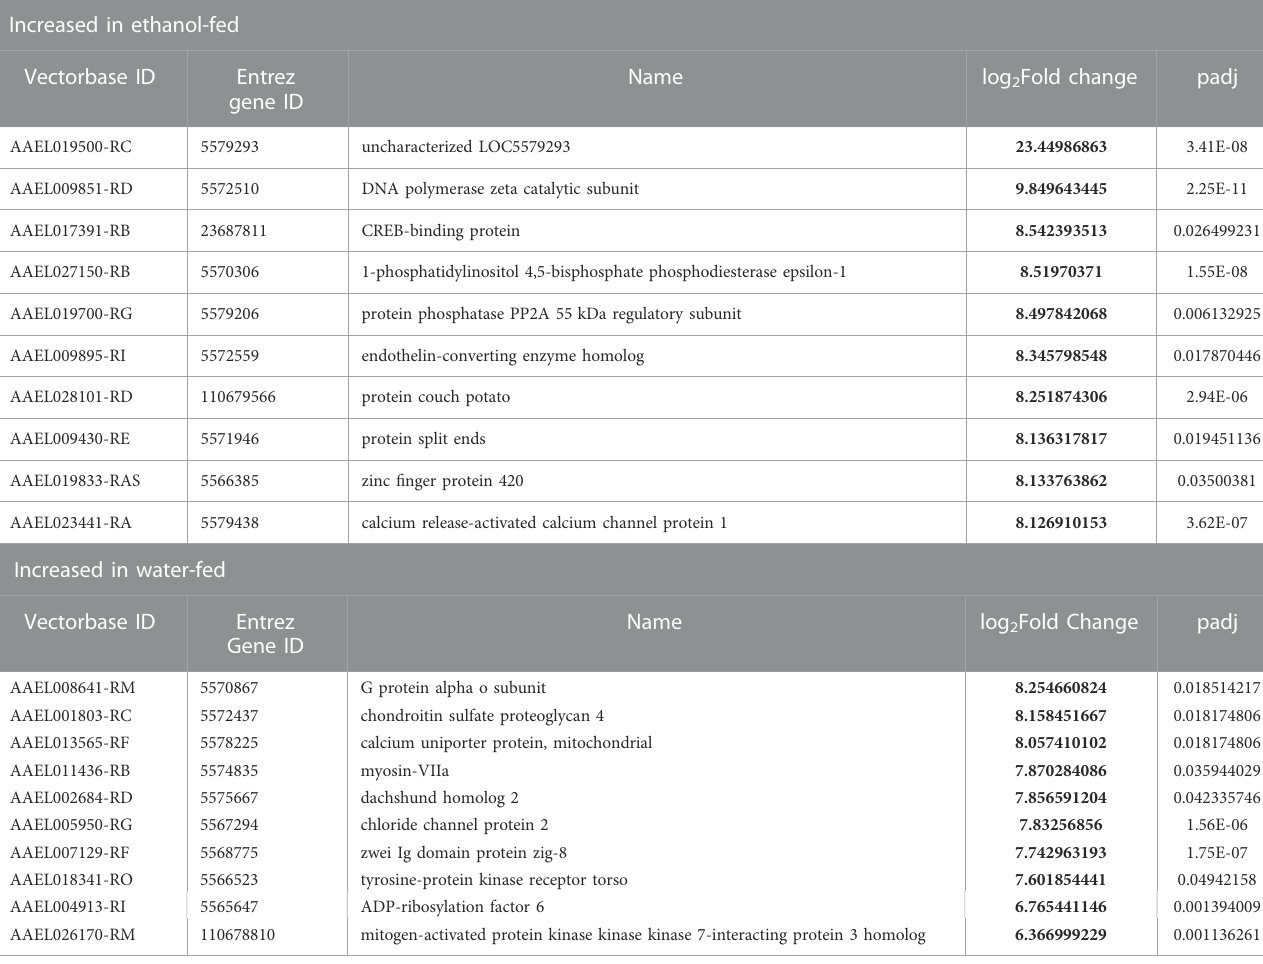
TABLE 3 Top ten genes with signi fi cantly different gene expression between ethanol-fed and water-fed irradiated male Ae. aegypti . Increased in ethanol-fed Vectorbase ID Entrez gene